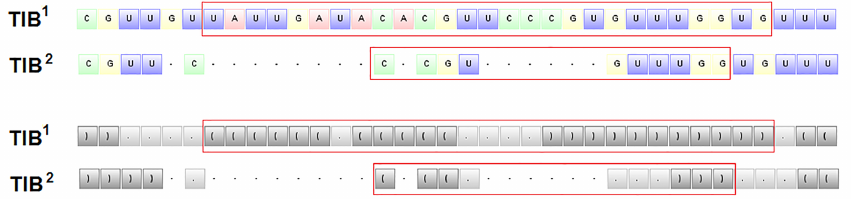
Fig. 2. Predicted general secondary structure for the ITS1 partial regions of Streptocephalus proboscideus (outgroup).